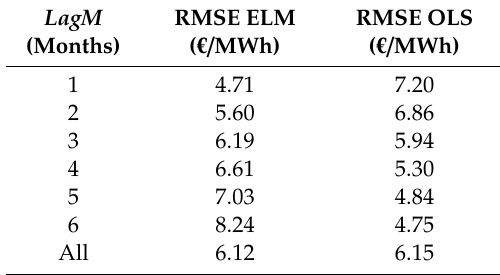
Table 3. Root mean square error (RMSE) values for the testing period for the extreme learning machine (ELM) neural network model and the ordinary least square (OLS) model.